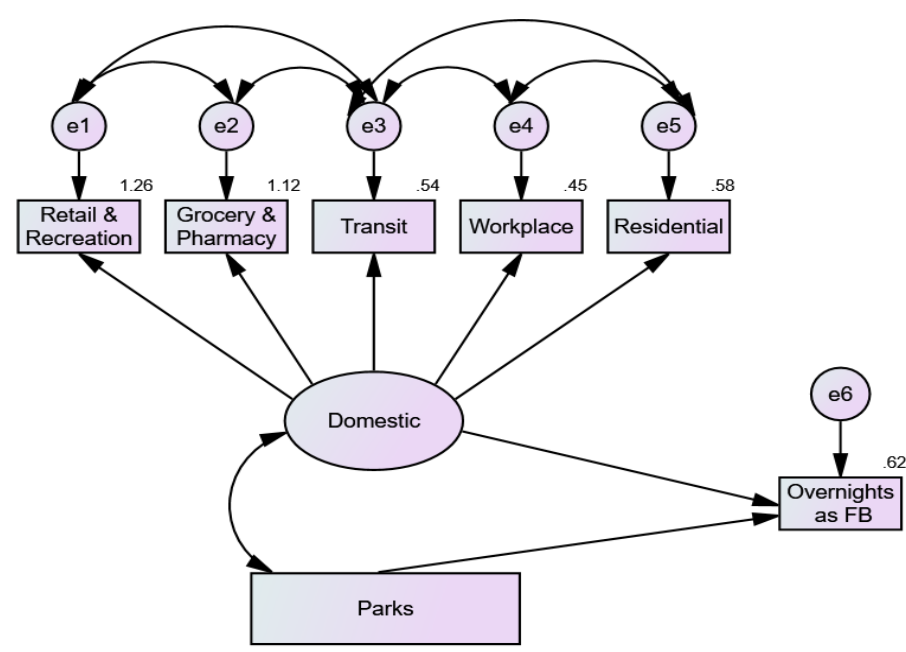
Figure 13. The standardized model. The hypothesis for the chi-square statistics is the reduced model (overidentified); this fits the data, as does the just-identified (full, saturated) model. The results of SEM by using AMOS 22.0 software indicate that the chi-square statistic for the estimated model is 107.694, df = 7 and p = 0.000. The unstandardized coefficients (estimate) and significant regression paths (P) are presented in Table 7, based on the maximum likelihood estimates method. The results show that all the regression paths are statistically significant for p < 0.05 for the unstandardized model. Table 7. Regression Weights and Squared Multiple Correlations.